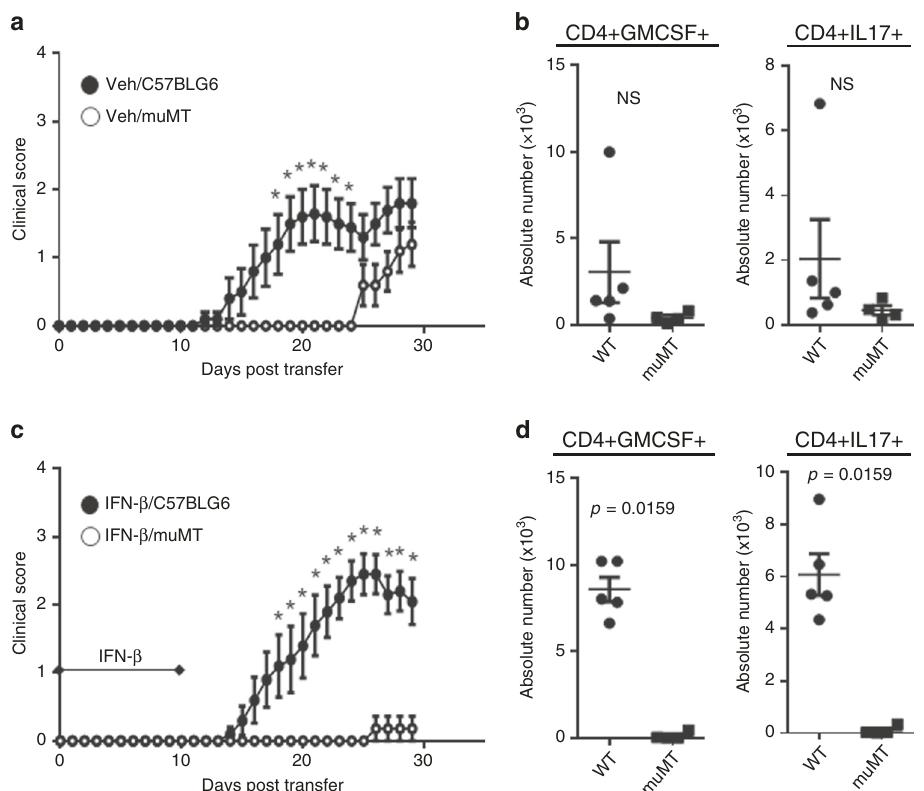
Fig. 8 B cell-de fi ciency attenuates IFN- β -treated TH17-EAE. TH17-EAE was induced in either C57BL/6 or µ MT mice and treated with IFN- β or vehicle. a Clinical scores of vehicle-treated C57BL/6 ( n = 10) and µ MT ( n = 10) mice with TH17-EAE. Data were pooled from two independent experiments. Mann – Whitney tests were performed to determine statistical signi fi cance ( P < 0.05). b Number of CD4 + T cells that express GM-CSF and IL-17 in spinal cords of vehicle-treated mice (day 29). c Clinical scores of IFN- β -treated C57BL/6 ( n = 10) and µ MT ( n = 11) mice with TH17-EAE. Data were pooled from two independent experiments. Mann – Whitney tests were performed to determine statistical signi fi cance ( P < 0.05). d Number of CD4 + T cells that express GM-CSF and IL-17 in spinal cords of IFN- β - treated mice (day 29). Statistical analysis was performed using two-tailed Mann – Whitney tests. Error bars indicate the S.E.M. Results are compiled from two independent experiments. Source data are provided as a Source Data fi